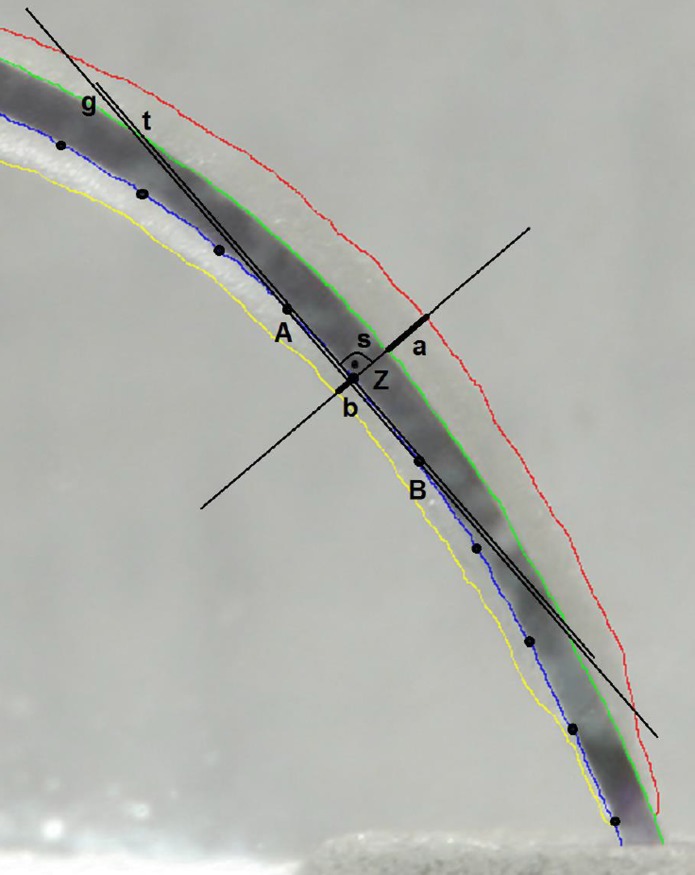
Schematic illustration of the function of the experimental software used to evaluate the centering ratios of the root canal preparations.Superimposed images with traced outlines of un-instrumented (green and blue lines) and instrumented (red and yellow lines) root canals with software assisted construction of tangents and perpendiculars crossing the outlines of the superimposed root canals. Z: current measuring point, A & B: neighbor auxiliary points at intervals of 15 pixels to Z, g: straight line constructed crossing A & B, t: tangent constructed intersecting Z by parallel shift to g, s: perpendicular intersecting g and t in Z, a & b: amount of canal wall removal detected by the software.